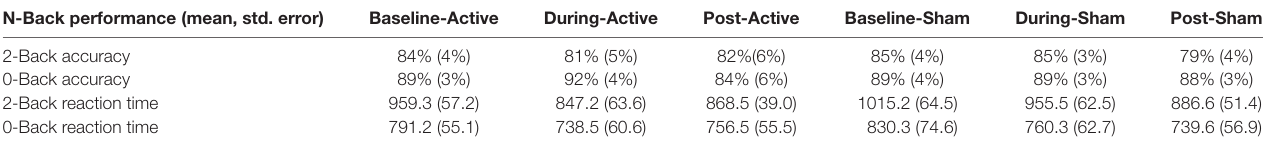
TABLE 3 | Mean percent task accuracy and standard error on 2-Back and 0-Back for each condition; mean reaction time and standard error in milliseconds for each condition. N-Back performance (mean, std.